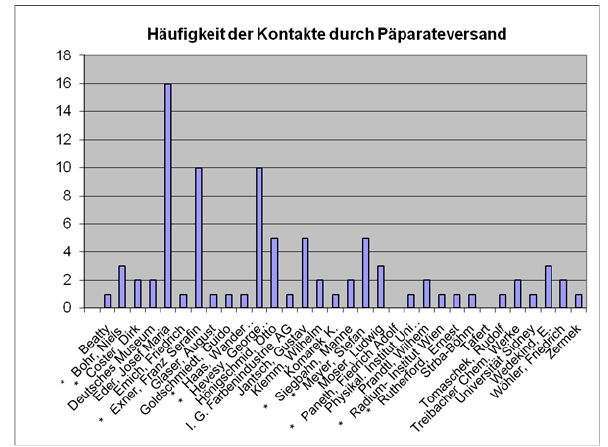
Figure 1. Frequency of contact through Eversand Compound.